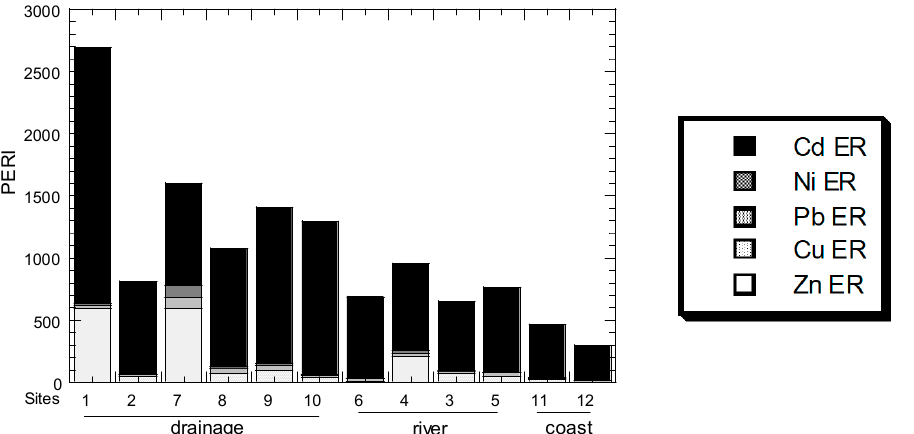
Figure 7. Values of potential ecological risk index (PERI) in drainage, river, and coast in the sediments collected from Malacca, Peninsular Malaysia.